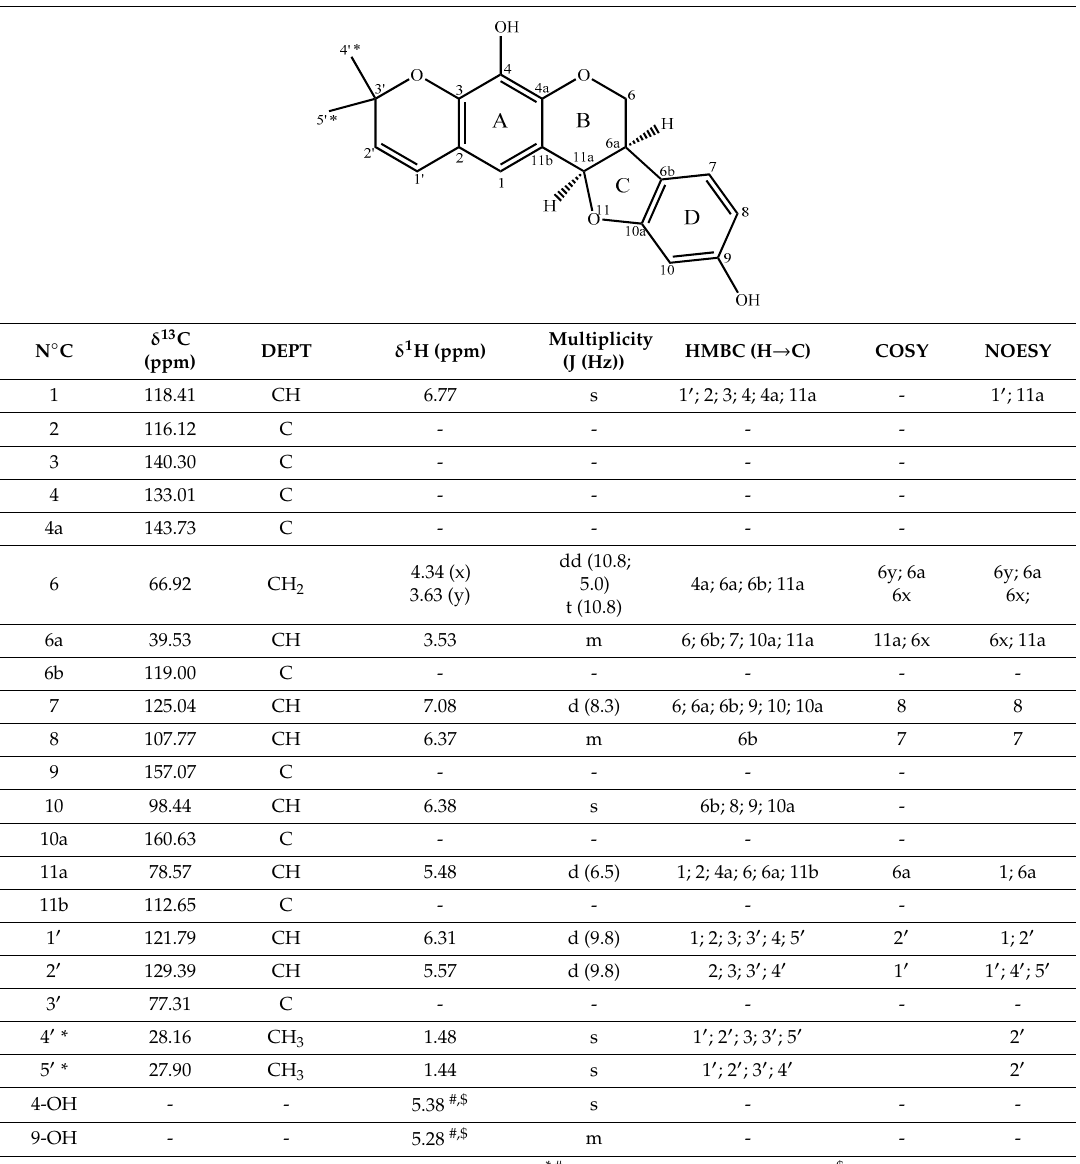
Table 3. Structure (relative stereochemistry) and NMR data of compound 3 .